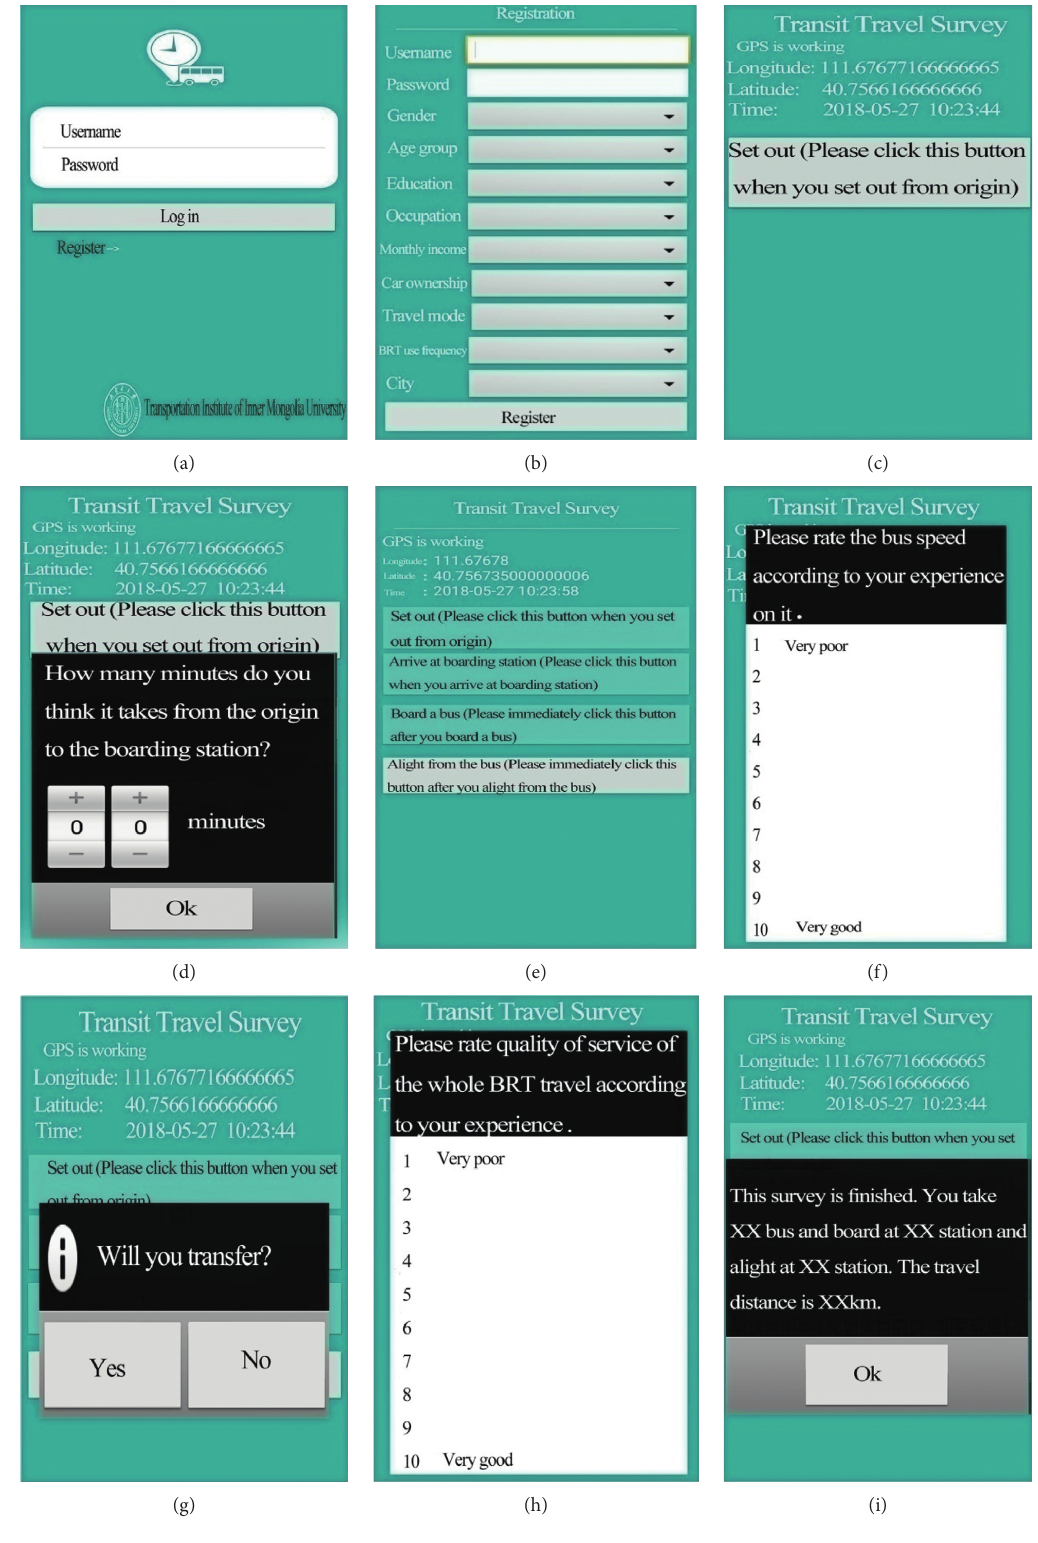
Figure 1: App interface